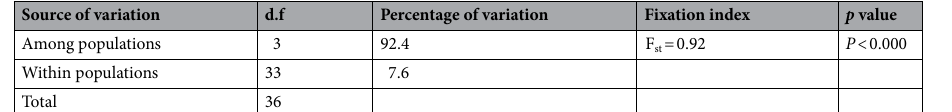
Source of variation d.f Percentage of variation Fixation index p